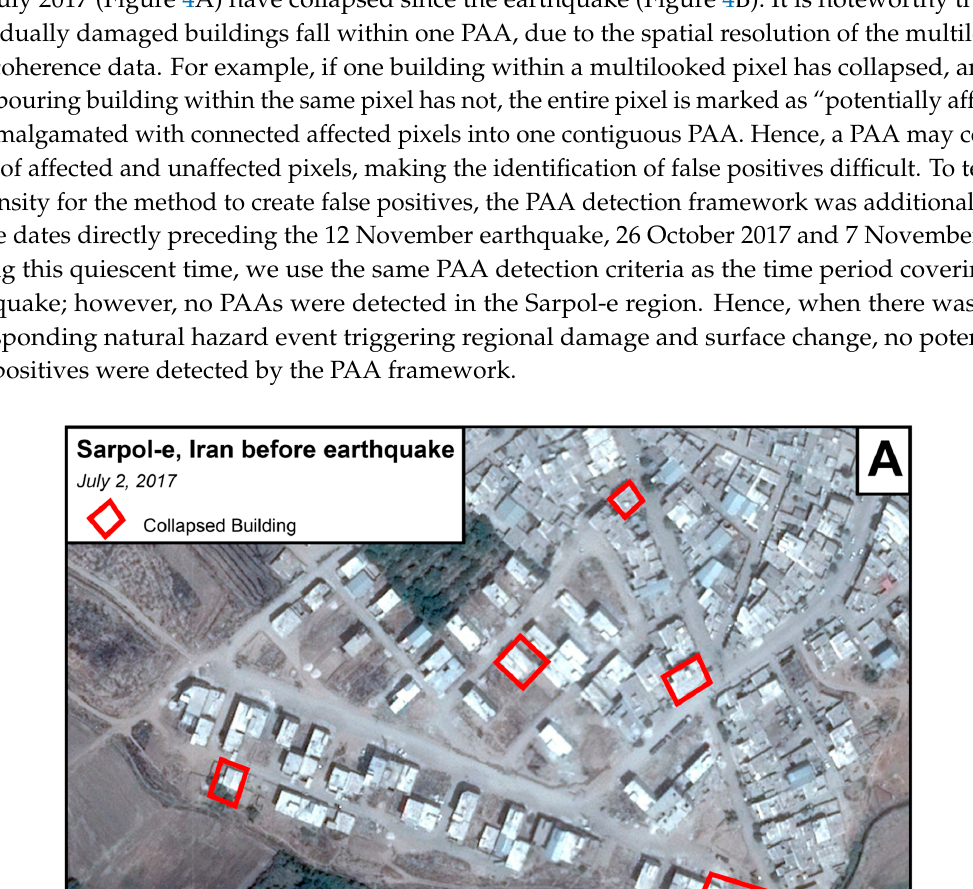
Table 2. Iran-Iraq Mw 7.3 PAA statistics for five most populous and largest detected PAAs (cf. Figure 2D).